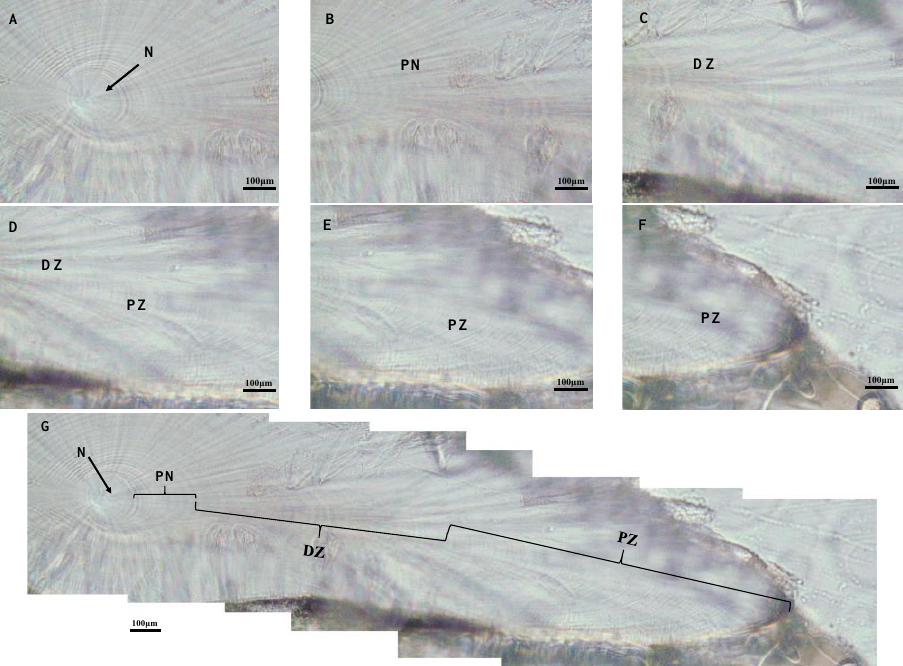
Figure 4. Statolith microstructure of S. oualaniensis from the waters of the Xisha Islands of the South China Sea (female with mantle length 138 mm, body weight 173 g, age 169 d). ( A ) The nuclear zone (N); ( B ) the post-nuclear zone (PN); ( C , D ) the dark zone (DZ); ( E , F ) the peripheral zone (PZ); ( G ) growth increments in microstructure.